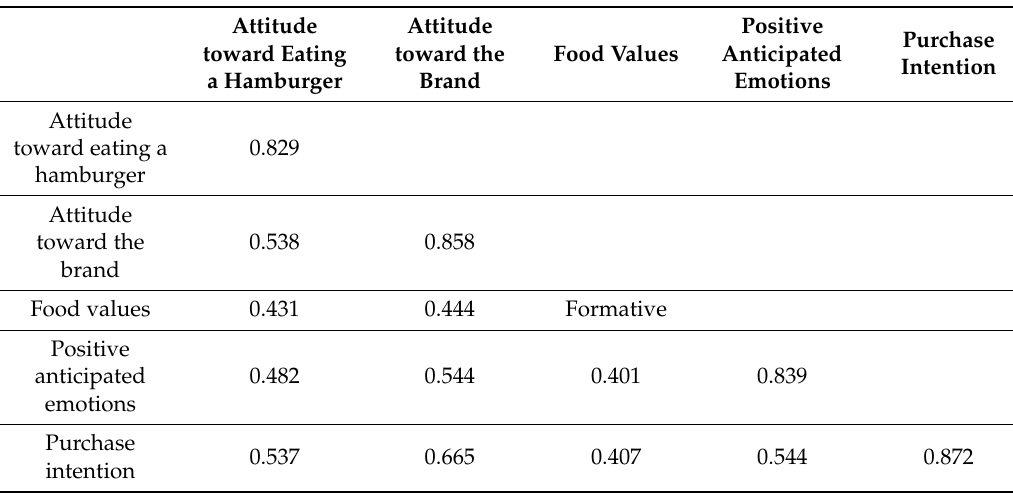
Table 4. Association